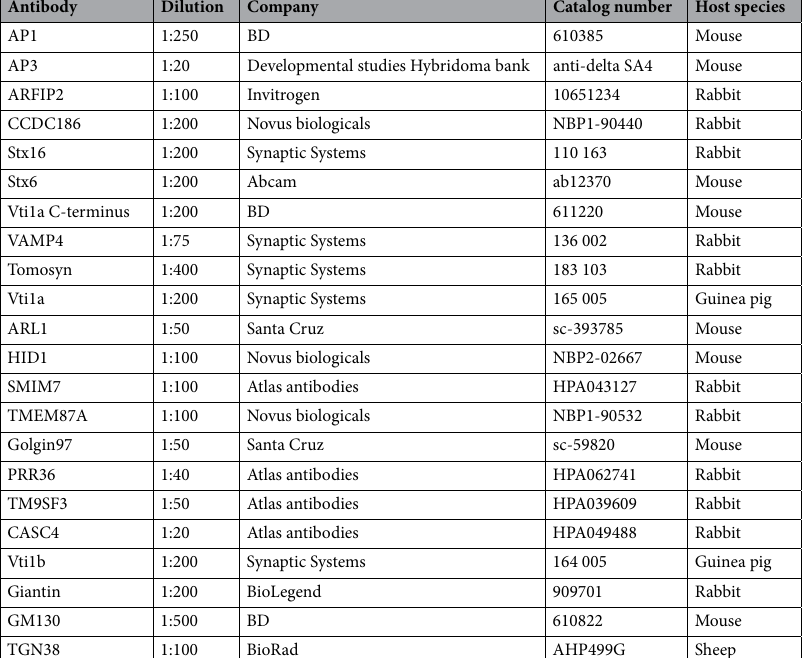
Table 1. Primary antibodies used for